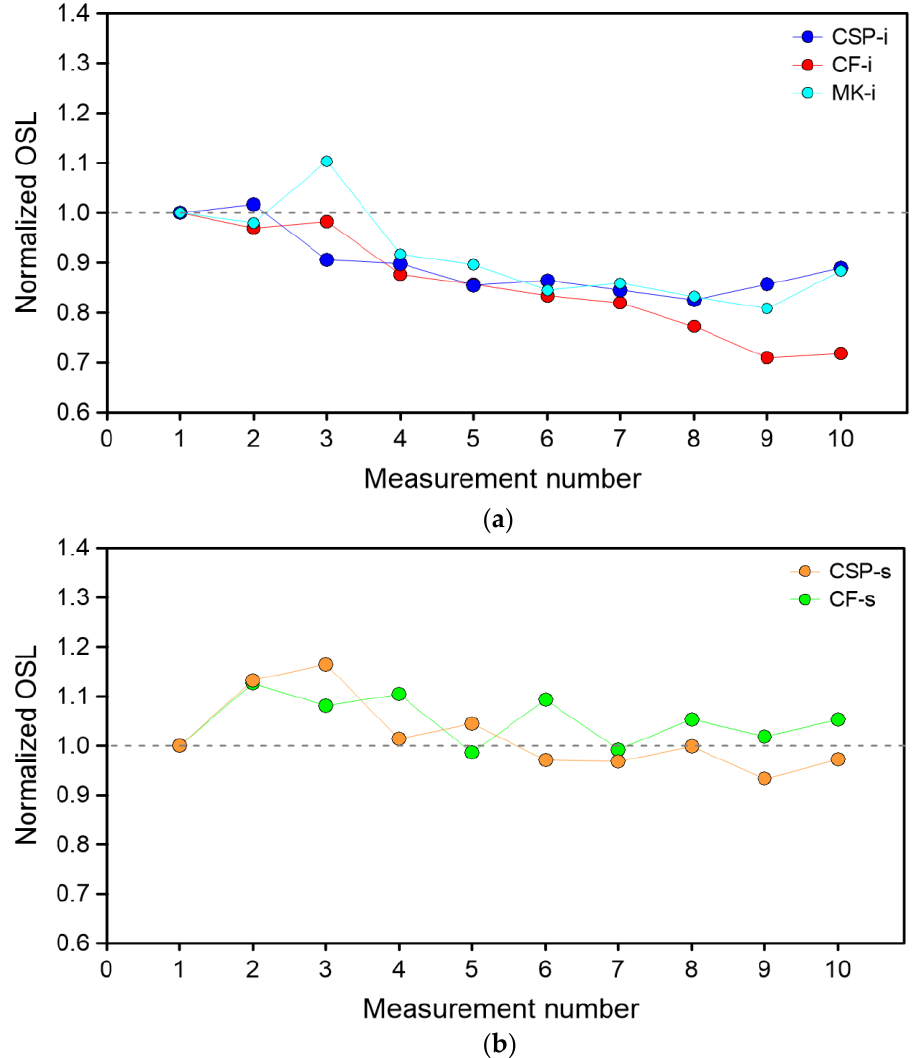
Figure 5. Sensitivity changes with the subsequent OSL measurement for the samples: ( a ) CSP-i, CF-i, MK-i, ( b ) CSP-s, CF-s.